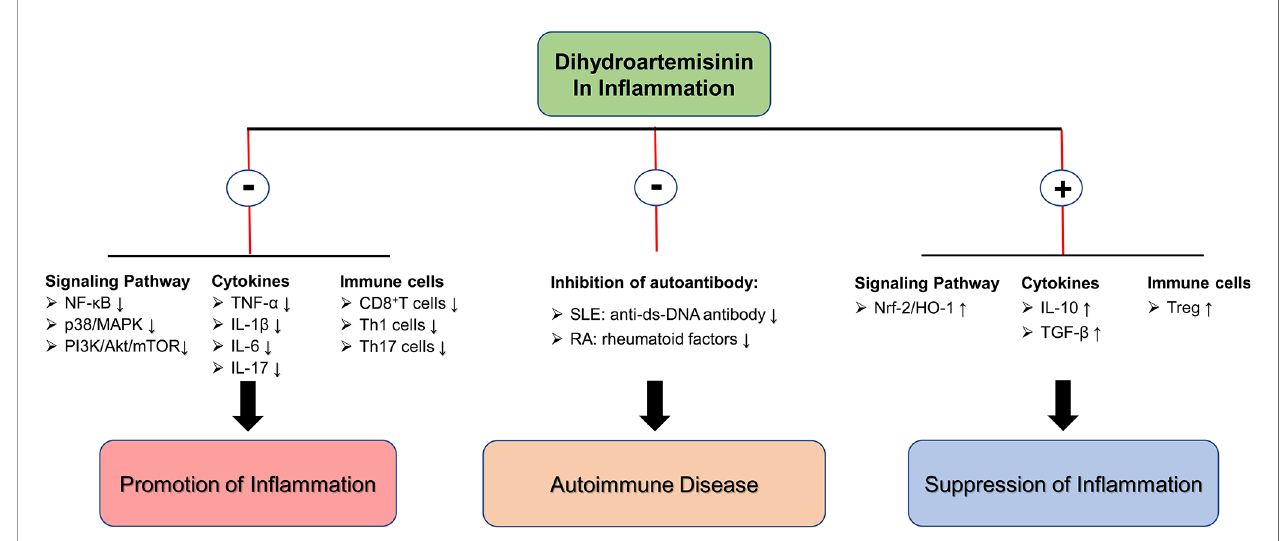
FIGURE 2 | The molecular mechanism of DHA in in fl ammation inhibition. ⊕ means the promoting effect of DHA. ⊖ means the suppressive effect of